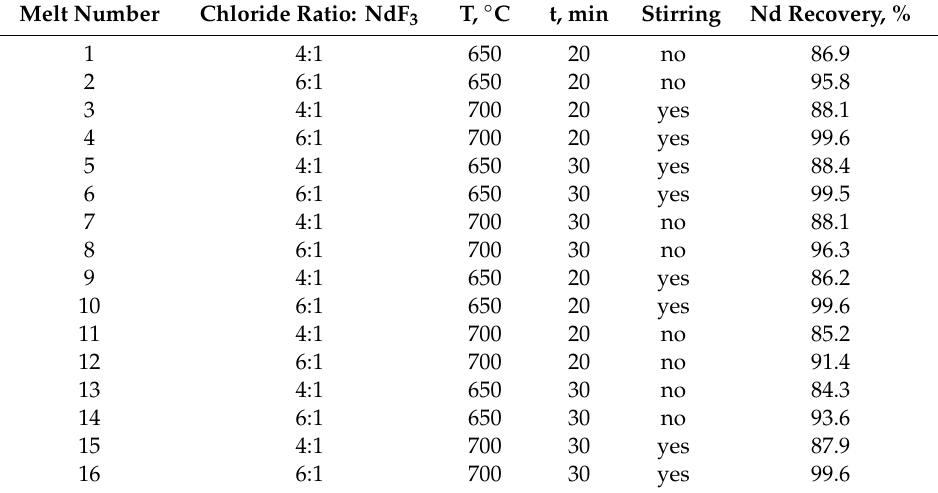
Table 2. Results of synthesis of Mg–Zn–Nd master alloy.